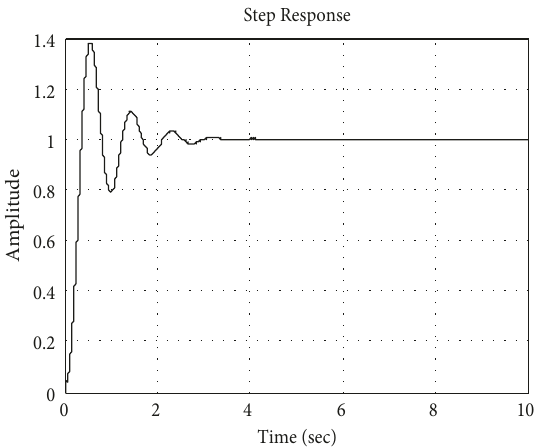
Figure 24: Response curve at 0.1 times β